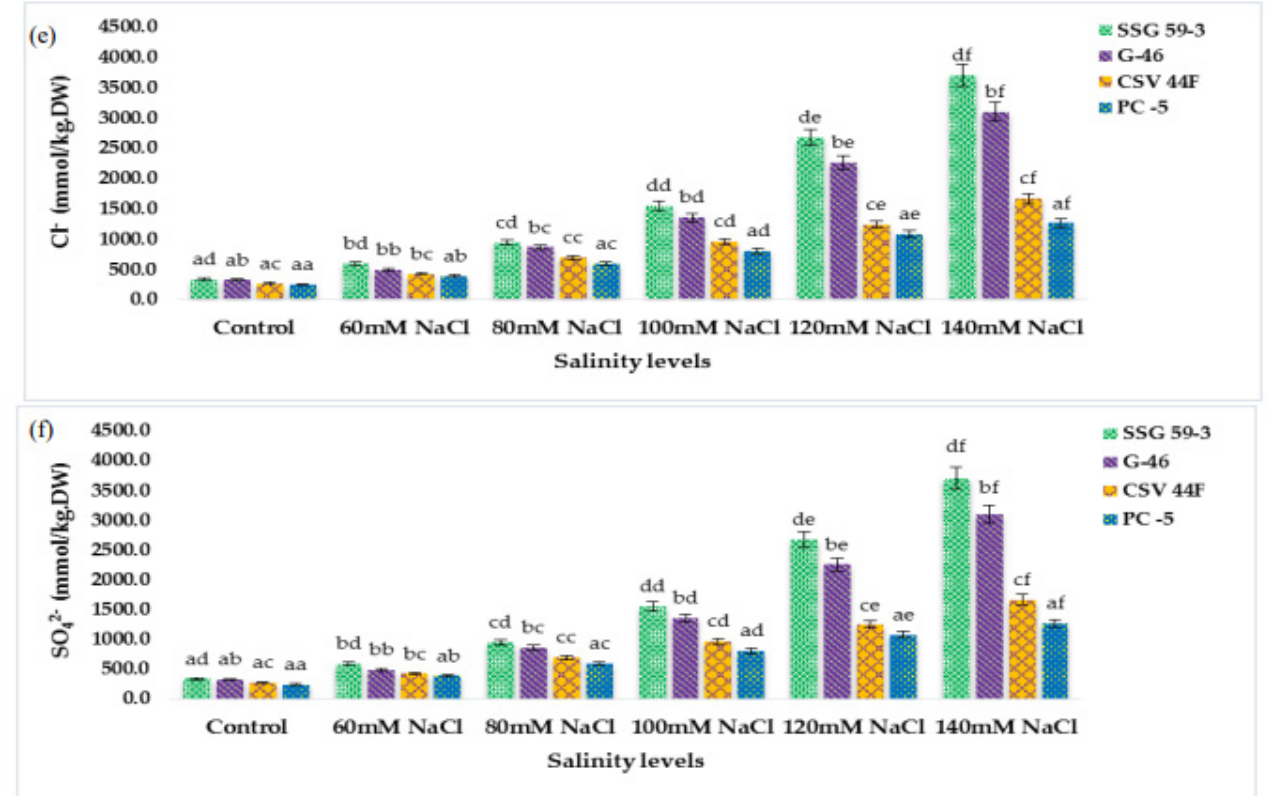
Figure 4. Accumulation of inorganic cations and anions of sorghum seedlings due to oxidative stress. ( a ) Na + content; ( b ) K + content; ( c ) Mg 2+ content; ( d ) Ca 2+ content; ( e ) Cl − content; ( f ) SO 42 − content. Values represent means ± S.E. a–f Values with different superscripts in the same row are significantly different at p <